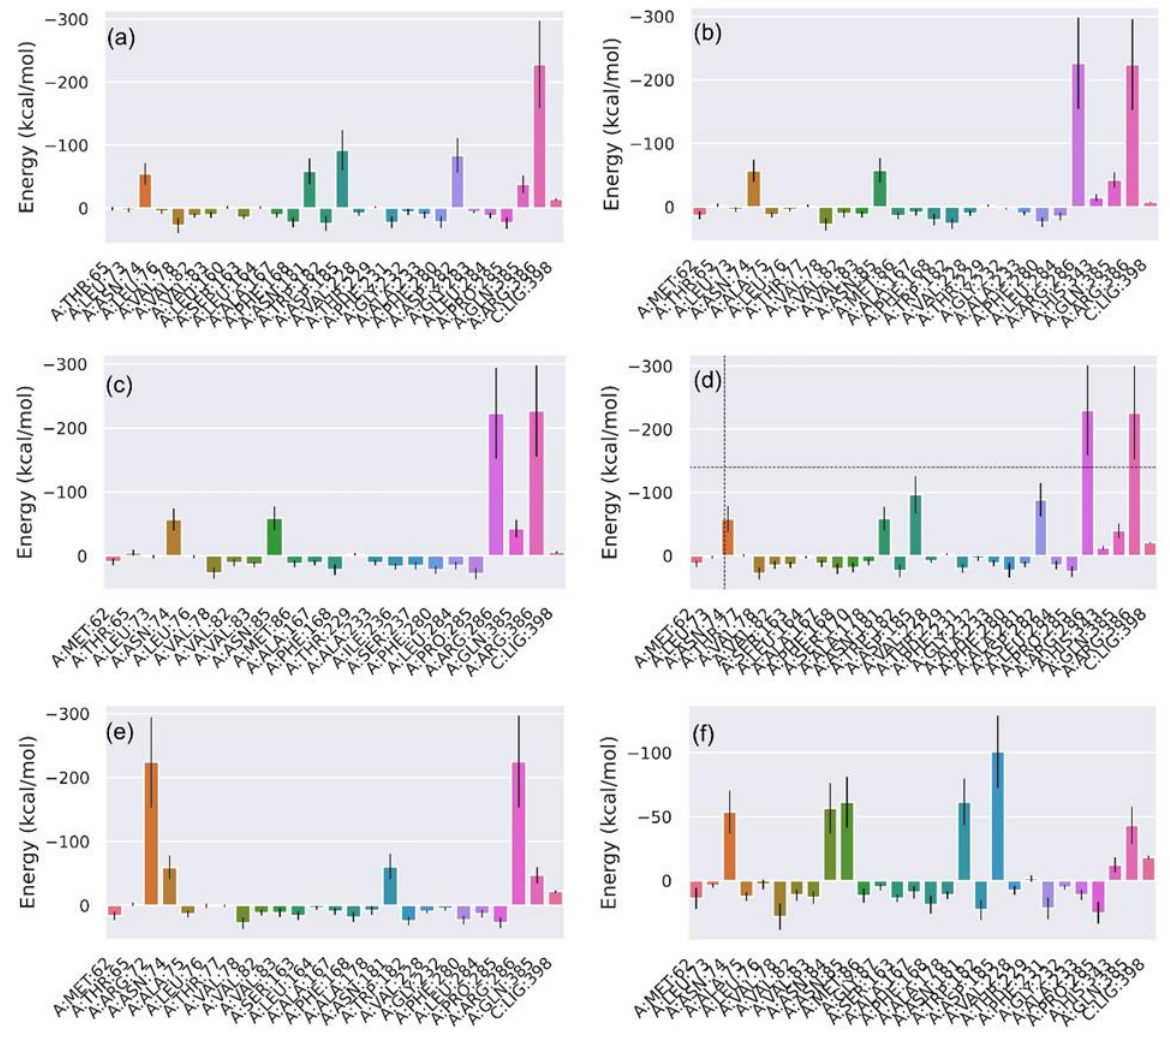
Figure 6. Free energy residue decomposition for binding site residues of CYP121 complexed with ( a ) Catechin 3,7,-Di- O -Galate, ( b ) Catechin 5,7,-Di- O -Gallate, ( c ) Catechin 5,4’ -Di- O -Gallate, ( d ) Ep- ifisetinidol-(4beta->8)-Catechin, ( e ) Catechin 3- O -Rutinoside, ( f ) Epicatechin (4b->6) Catechin with protein complex.